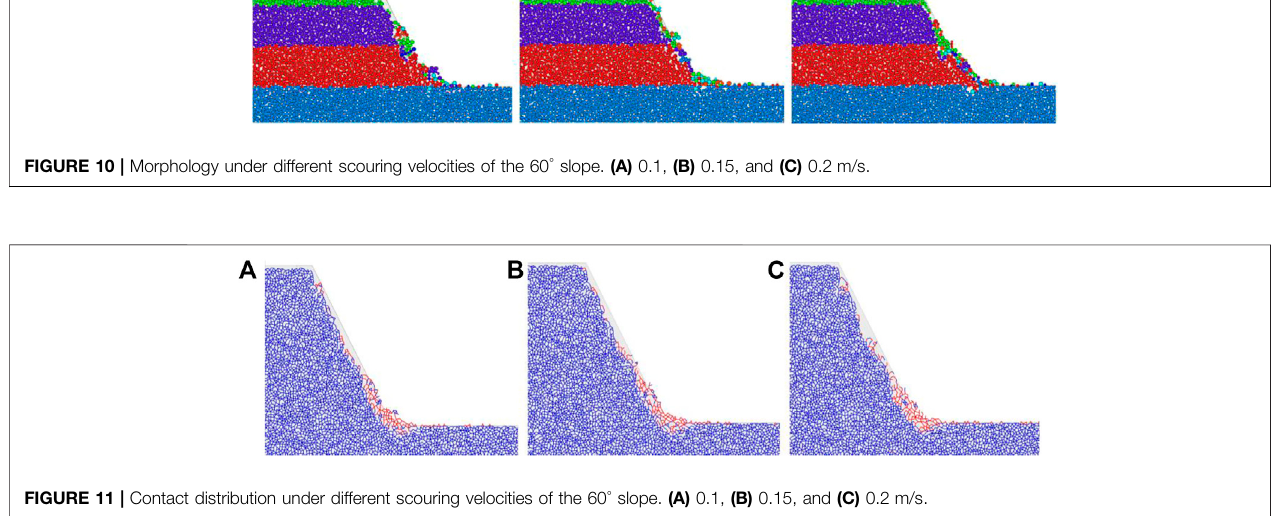
FIGURE 11 | Contact distribution under different scouring velocities of the 60 ° slope. (A) 0.1, (B) 0.15, and (C) 0.2 m/s.